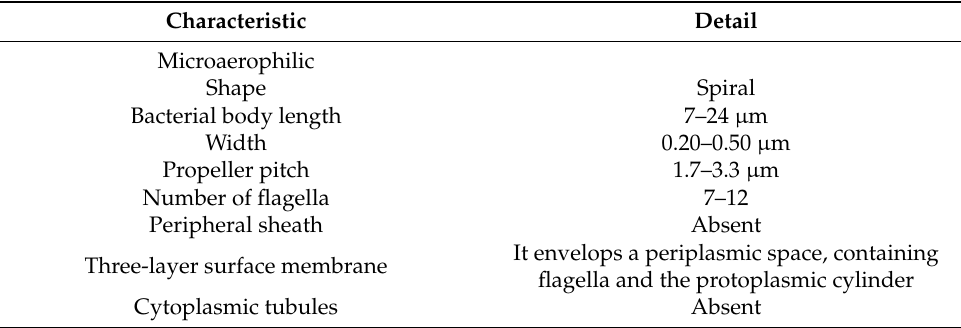
Table 5. Characteristics of Borrelia Lyme